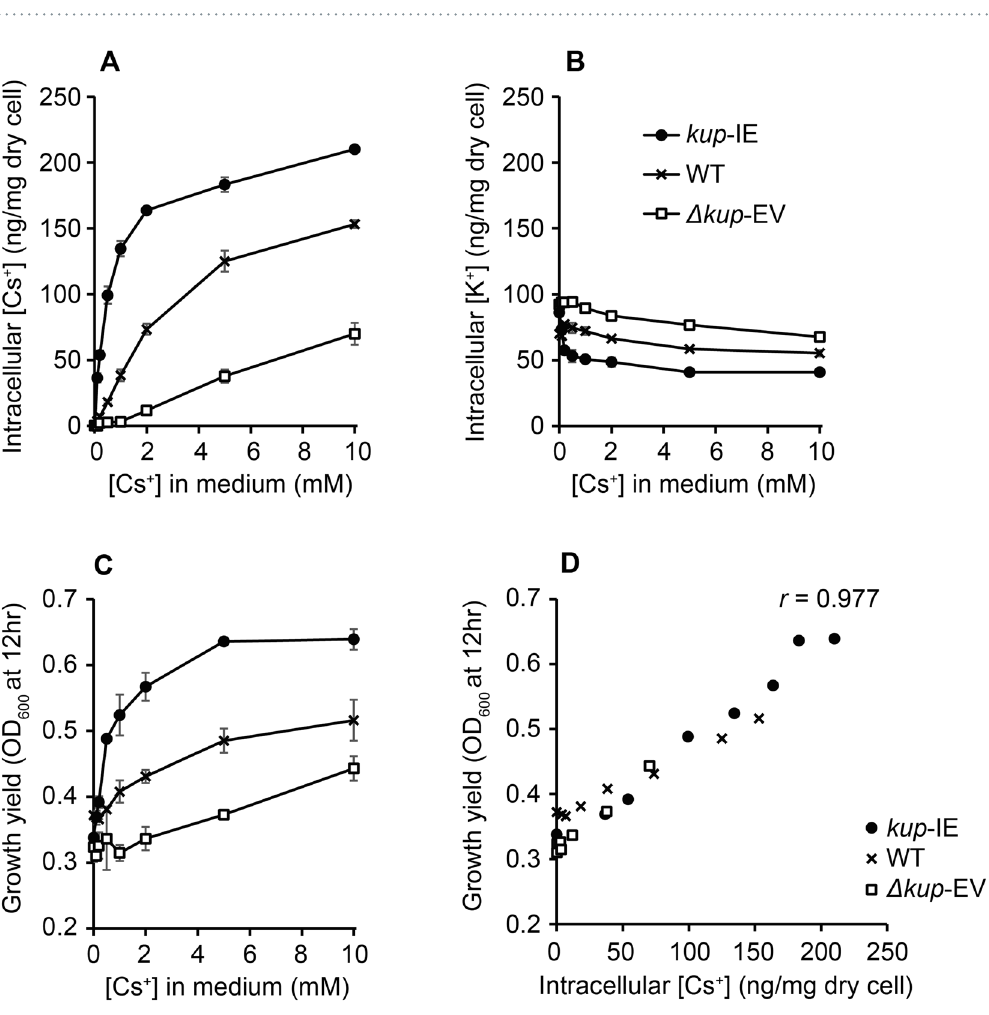
Figure 3. The effects of Cs + on the growth of the E. coli strains under K + -deficient conditions. The intracellular Cs + ( A ) and K + ( B ) concentrations, and the growth yields ( C ) were measured after 12 hr cultivation in the K + -deficient medium supplemented with 1 mM of arabinose. ( D ) The growth yields were plotted against corresponding intracellular Cs + concentrations. Data are presented as means of three independent cultures, and error bars represent standard